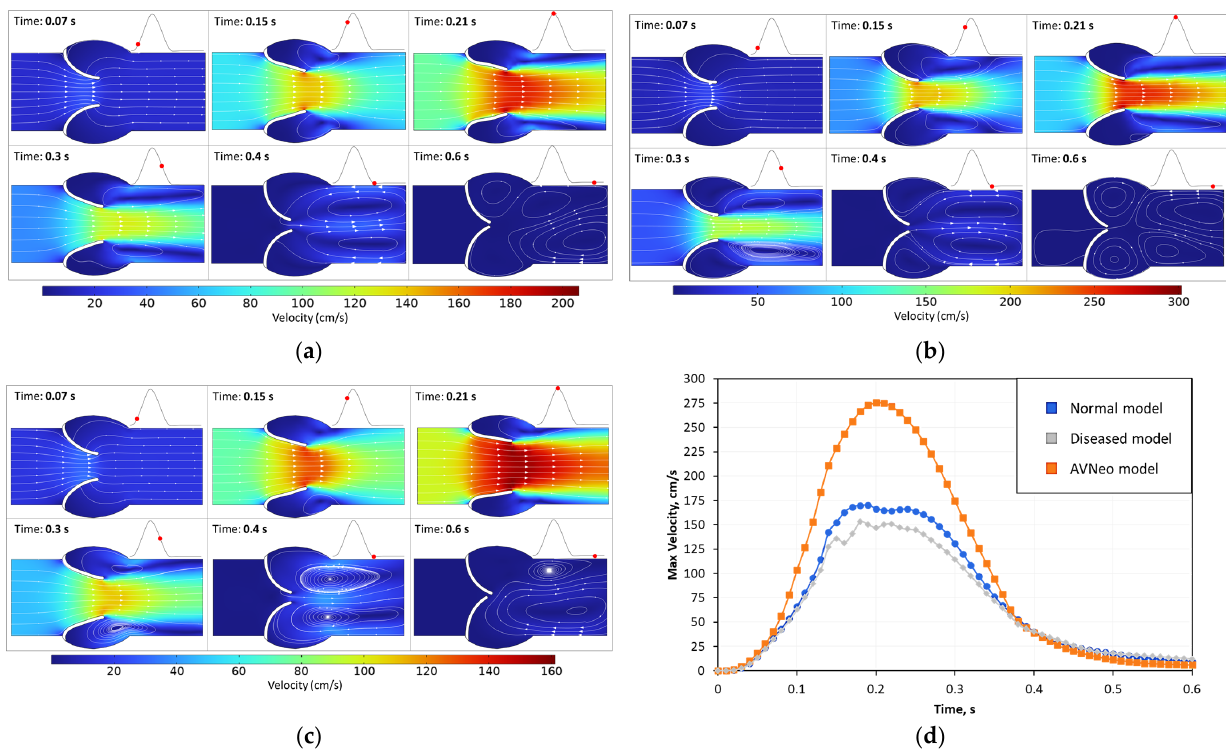
Figure 3. Velocity field and streamlines for ( a ) healthy state, ( b ) diseased model, ( c ) AVNeo model, and ( d ) maximum velocity. Time points are shown with red dots on the cardiac cycle. Flow direction is demonstrated with